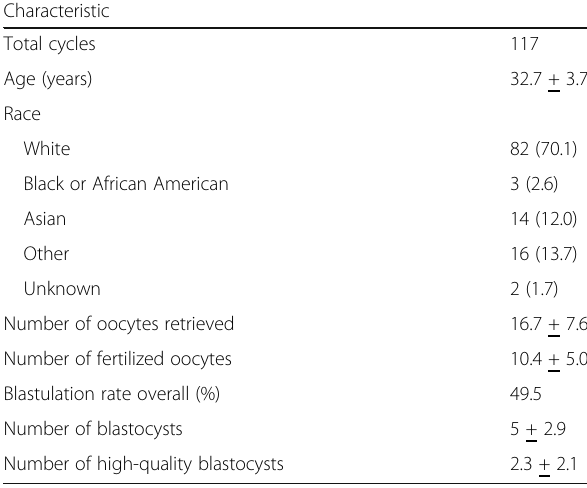
Table 1 Overall patient and cycle characteristics Characteristic